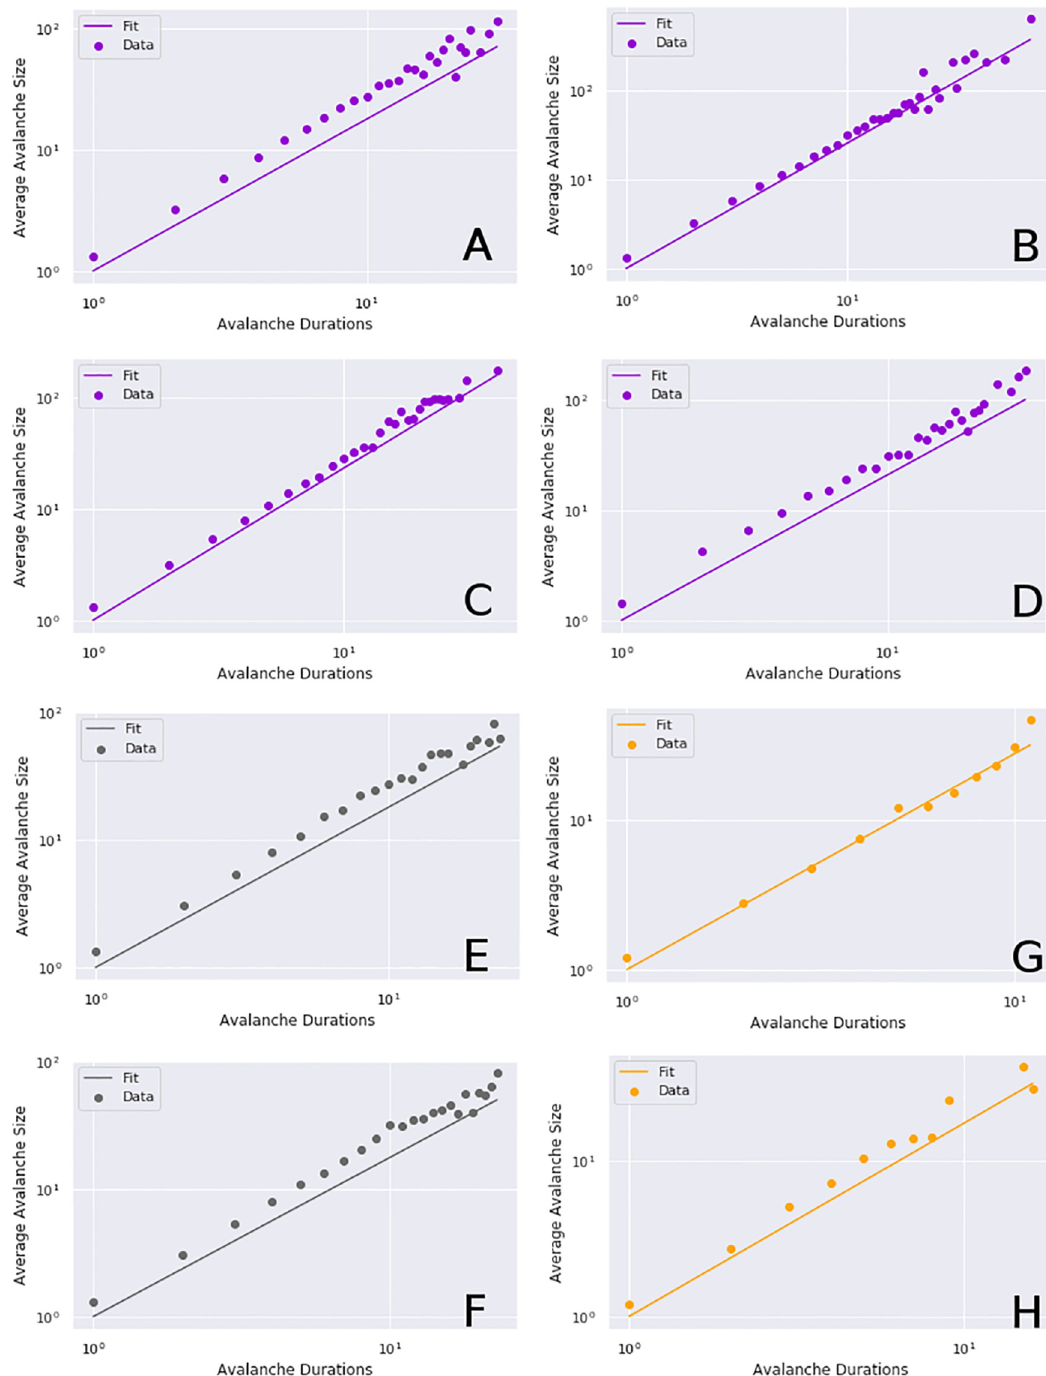
Fig 8. The average avalanche size for a given duration by condition. The color mapping is the same as in Fig 7: purple corresponds to the awake condition ( A, B, C, D ), grey to ketamine ( E, F ), and orange to propofol ( G, H ). Each plot includes two scans: the anaesthesia condition (propofol or ketamine) and the associated pre-anesthesia awake condition. In all cases there is a clear linear relationship between the average avalanche size for a given duration. Such a relationship is considered necessary, but not sufficient, to conclude a system is displaying critical dynamics